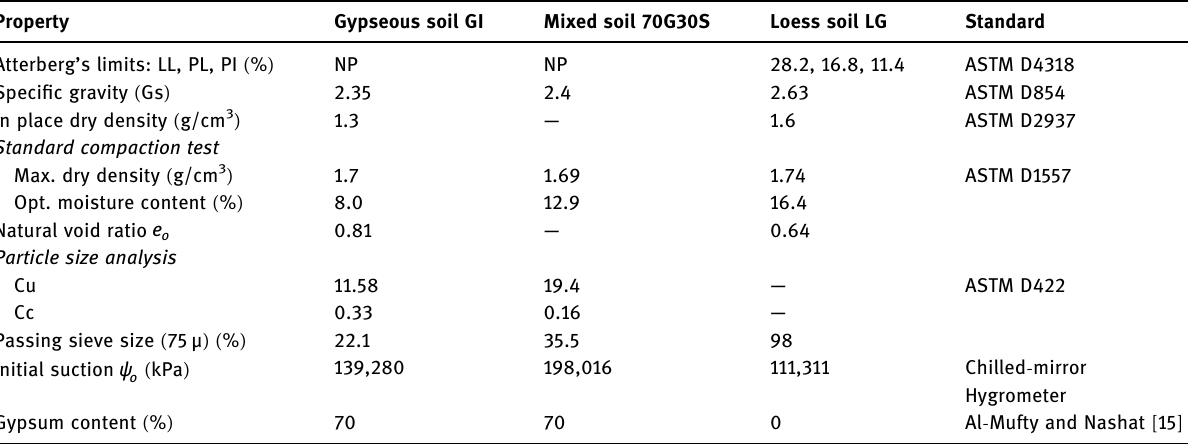
Table 1: Summary of physical properties of the soil samples